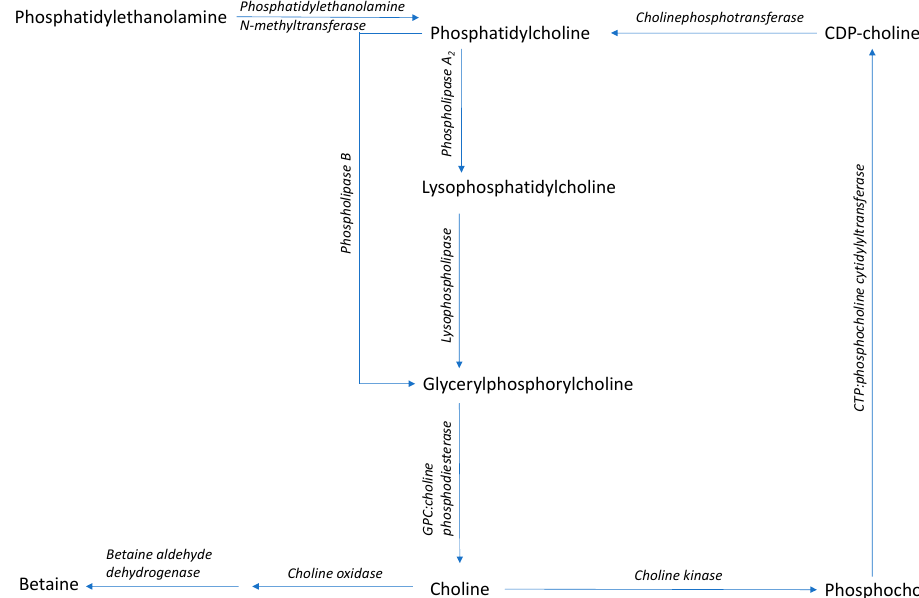
Figure 2. Synthesis and metabolism pathway of α -glycerylphosphorylcholine (Adapted from Li and Vance 2008 [70]; Gallazzini and Burg 2009 [71]). The blue area represents processes of the Kennedy Pathway, and the green area represents the synthesis of phosphatidycholine via methylation of phosphatidylethanolamine.